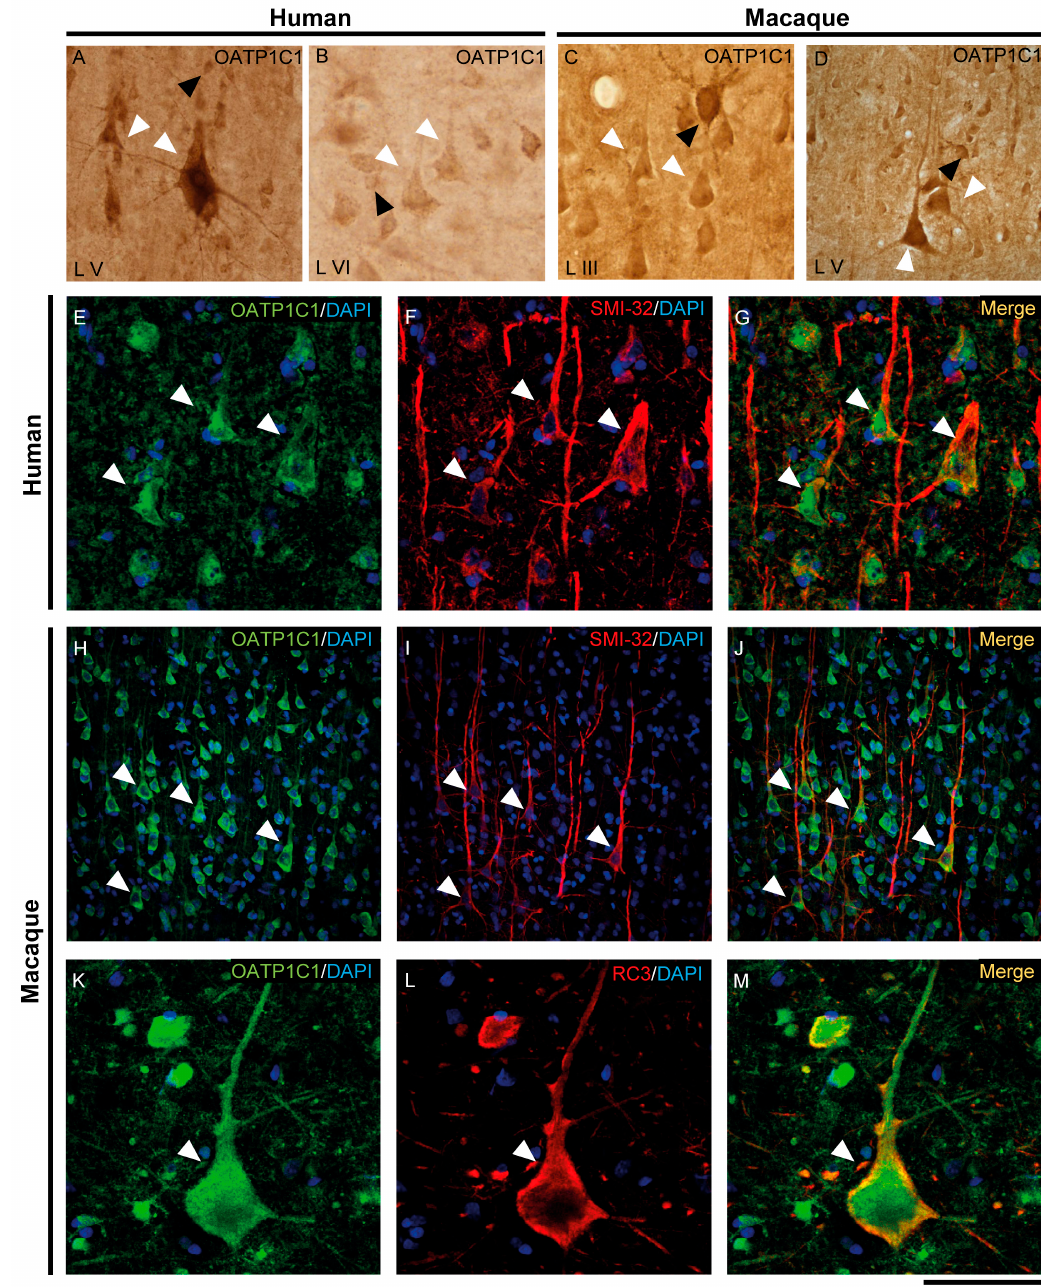
Figure 4. Expression of OATP1C1 in pyramidal neurons of the human and macaque motor cortex. Representative brightfield photomicrographs show immunostaining for OATP1C1 in layers V ( A ) and VI ( B ) of the human motor cortex and layers III ( C ) and V ( D ) of the macaque motor cortex. ( E – G ) Confocal microscope images for OATP1C1 (green, E ) and the pyramidal neuron marker SMI-32 (red, F ) immunostaining in the human cortex. ( G ) Merged image showing the colocalization of both signals. ( H – M ) Confocal microscope images for OATP1C1 (green, H , K ), SMI-32 (red, I ) and neurogranin/RC3 (red, L ) immunostaining in the macaque cortex. ( J , M ) Merged confocal photos, respectively, showing the colocalization of the signals. Counterstaining with DAPI (blue) shows nuclei of all cells. White arrowheads point to pyramidal neurons. Note that the signal can be identified in the membrane, cytoplasm, and apical and basal dendrites. Black arrowheads point to neurons with interneuronal morphology. L III–VI: layers of the cerebral cortex. Scale bar = 120 µ m ( A , D , H – J ), 60 µ m ( B , C ), 40 µ m ( E – G ), 50 µ m ( K – M